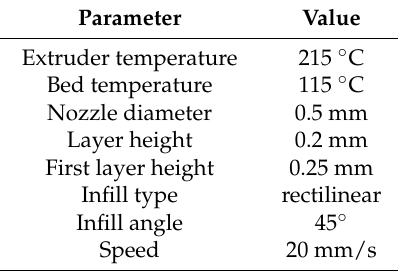
Table 1. Printing